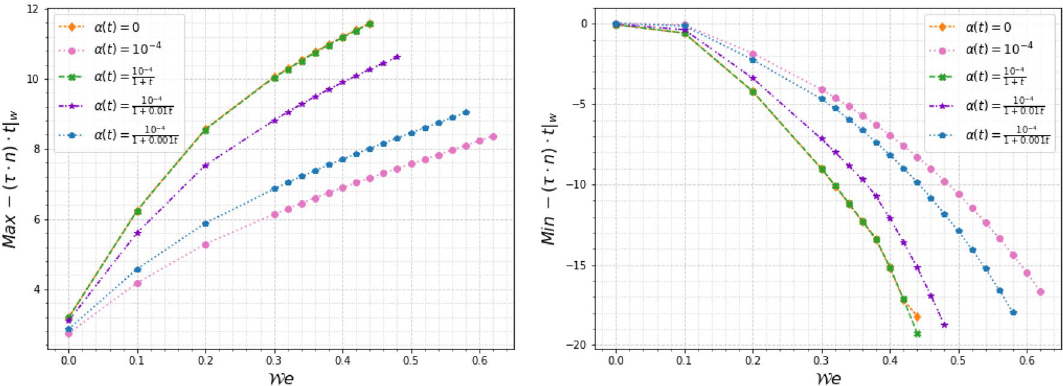
Fig. 10 Plots of the maximum (left) and minimum (right) values of stress tension −( 𝝉 ⋅ n ) ⋅ t